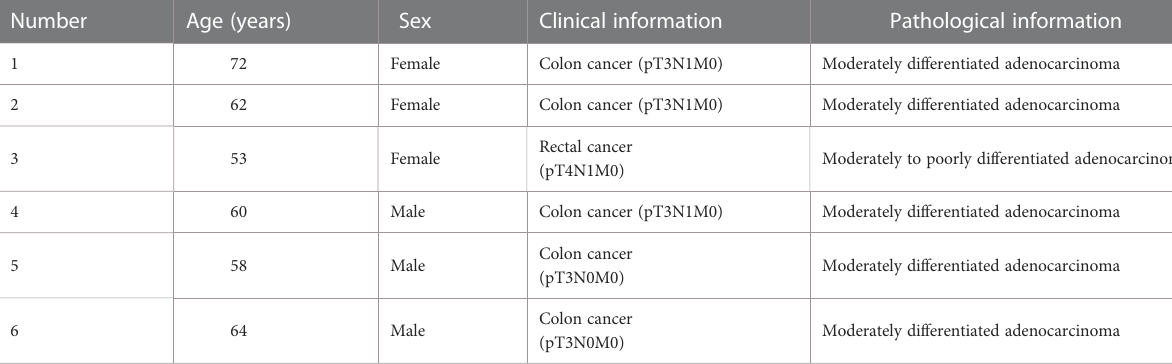
TABLE 1 Clinical and pathological information of six CRC